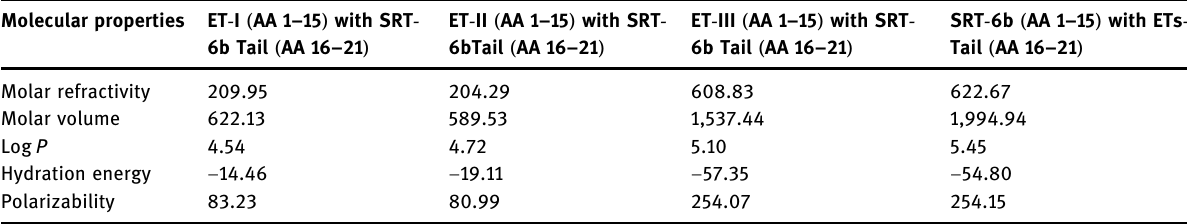
Molecular properties ET - I ( AA 1 – 15 ) with SRT